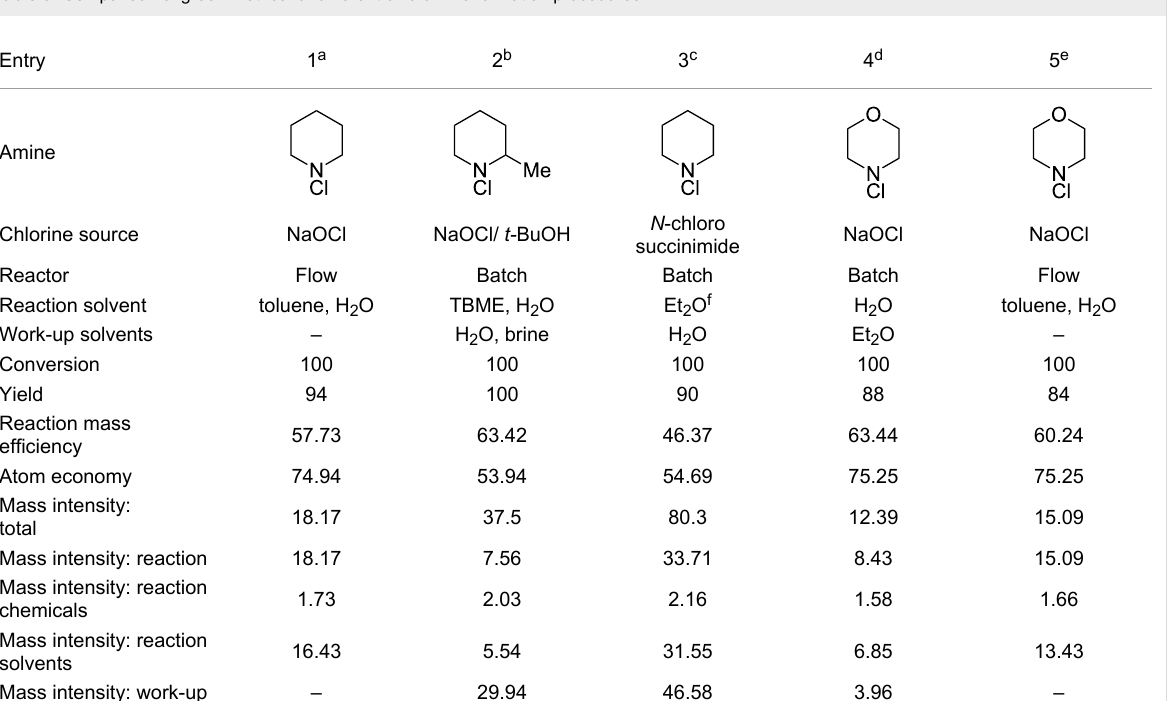
Table 3: Comparison of green metrics for different chloramine formation